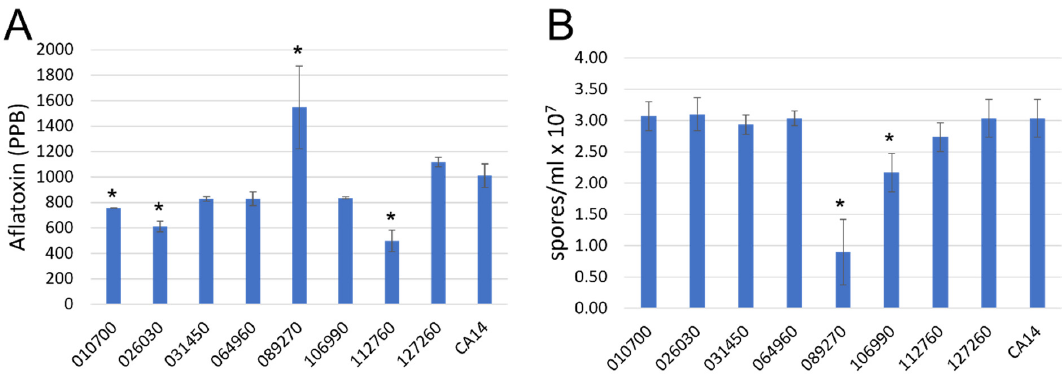
Figure 3. Transcription factor knockout strains exhibit altered sporulation and aflatoxin production. ( A ) Aflatoxin extracted from PDA medium after 7 days of growth from the respective transcription factor knockout strains. ( B ) Spore counts obtained from transcription factor knockout strains grown on PDA. Error bars represent the standard deviation. Asterisks (*) represent different LS means from CA14 at α <